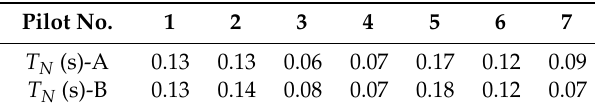
Figure 9. The box graphs for lead T L and lag T I time constants. Table 2. Mean values of pilots’ neuromuscular time constant T N (A—the first testing set; B—the second testing set).